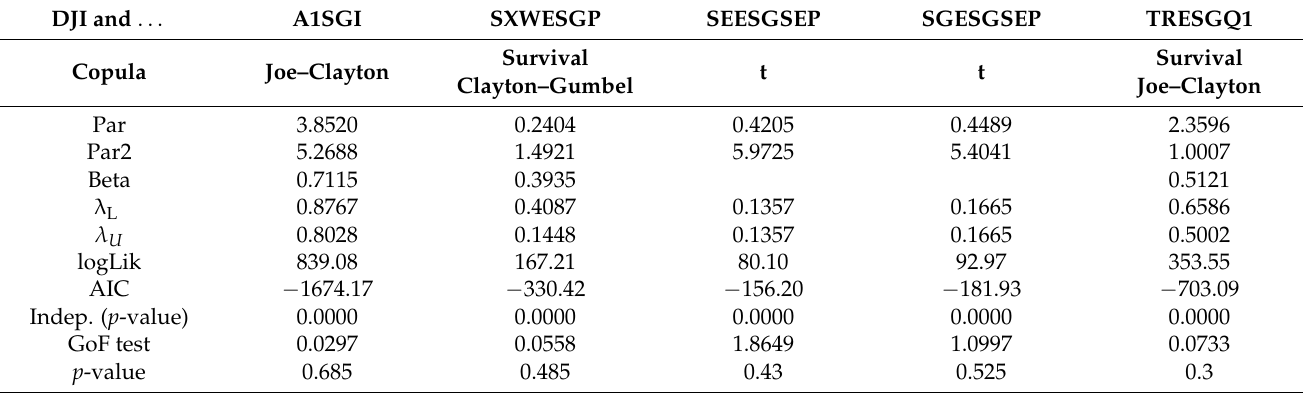
Table 12. Dependence structure for the DJI and ESG indices, 4 January 2017–31 December